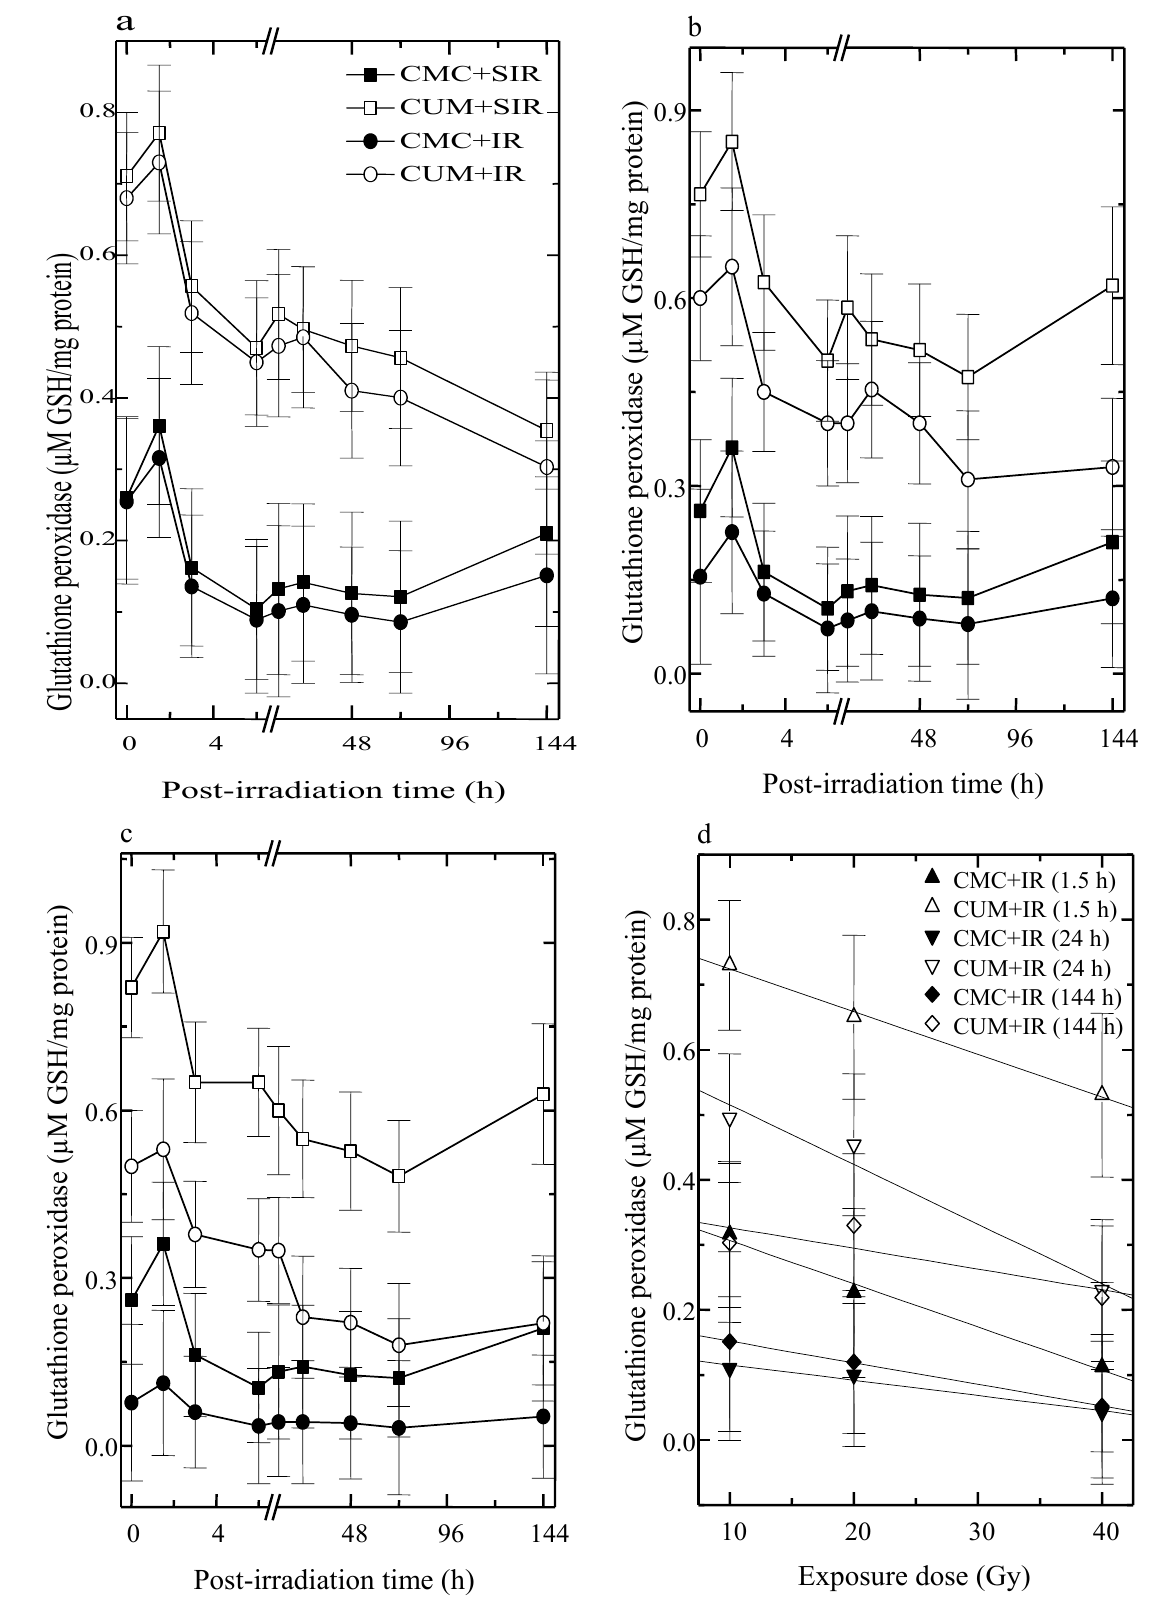
Figure 2. Effect of curcumin on glutathione peroxidase activity in the skin of mice exposed to different doses of fractionated γ-radiation. ( a ) 10 Gy ( b ) 20 Gy ( c ) 40 Gy and ( d ) dose response